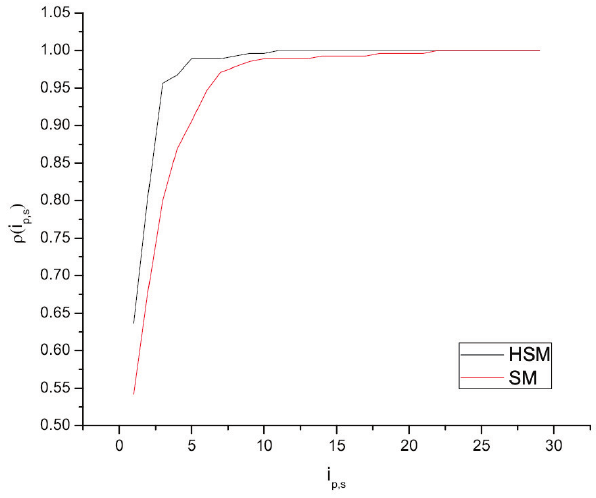
Figure 1. Performance profiles for the HSM and SM methods regarding the number of iterations metric.